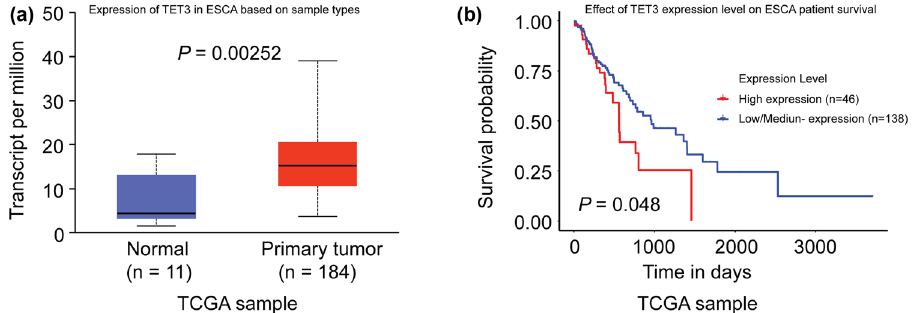
Figure A1: Overexpression and knockdown of TET3 in ESCC cells. ( a ) Fluorescence microscopy con fi rmed that TET3 was located in cytoplasm and nuclei ( scale bar = 50 μ m ) at 72 h after infection with lentiviral vectors ( MOI = 20 ) . ( b ) Western blot assay was used to detect the protein level of TET3 in OE and KD cell sublines.